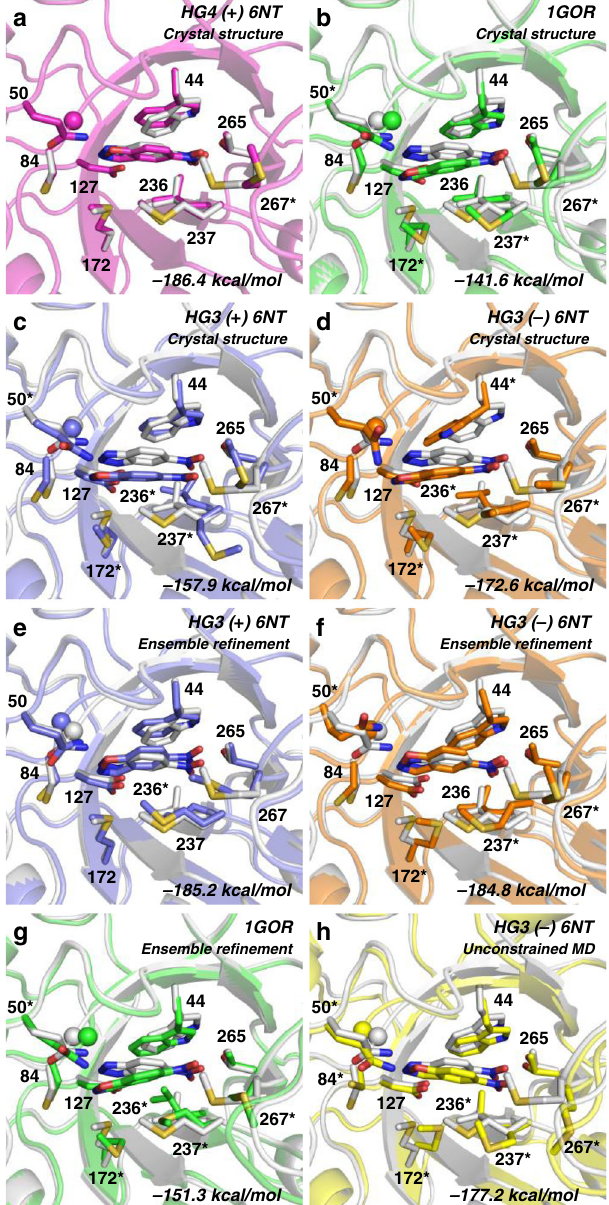
Fig. 4 Computational design of HG4 on various backbone templates. The HG4 crystal structure with bound 6-nitrobenzotriazole (white) is overlaid on the HG4 design models (colored) obtained using the crystal structure of ( a ) HG4 with bound 6-nitrobenzotriazole, b Thermoascus aurantiacus xylanase 10 A (PDB ID: 1GOR), c HG3 with bound 6-nitrobenzotriazole, or ( d ) HG3 without 6-nitrobenzotriazole. e – h the HG4 design models obtained using the template prepared by ensemble re fi nement or unconstrained molecular dynamics (MD) that gave the best energy following repacking. PHOENIX energies of design models after repacking are indicated at the bottom right. For reference, the energy of the HG4 crystal structure with a bound transition state is − 186.7 kcal/mol. In all cases, the transition state and transition-state analogue are shown at the center of the barrel. Side chains of all residues forming the binding pocket are shown with the exception of Ala21 and Pro45, which were omitted for clarity. The sphere shows the alpha carbon of Gly83. Asterisks indicate residues that adopt side-chain rotamers varying by >20 degrees around one or more side-chain dihedrals between the design model and crystal